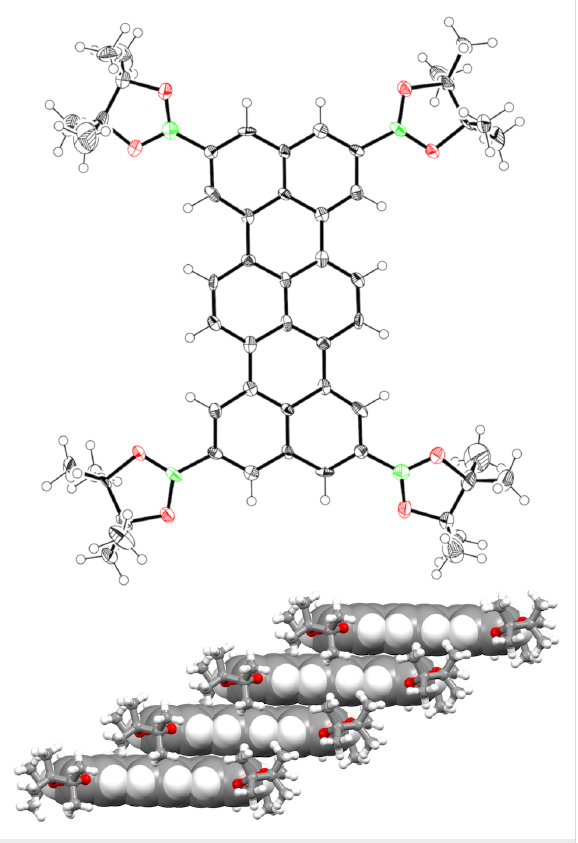
Figure 2: (Top) Single crystal X-ray structure of TB4 . The thermal ellipsoids are scaled at 50% probability. (Bottom) Packing diagram of TB4 . The solvent molecules are omitted for clarity.